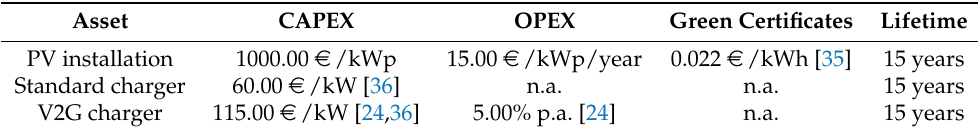
Table 4. Characterization of different assets at the charging locations (n.a. = not applicable).